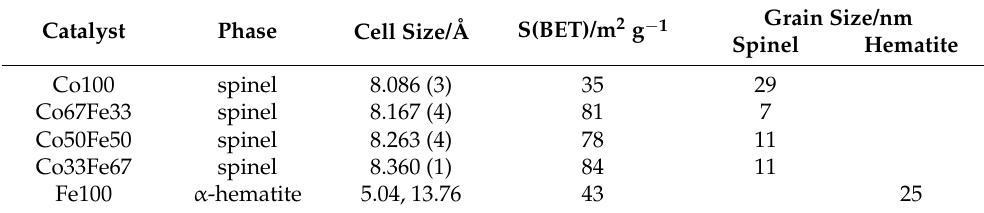
Figure 4. Powder XRD patterns of the Co-Fe catalysts. Spinel ( (cid:3) ), α -hematite ( ♦ ). Table 5. Phase and textural characterisation of Co-Fe oxide